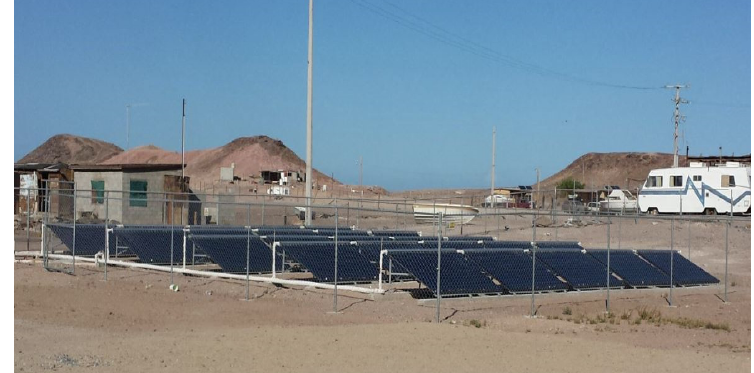
Figure 1. Evacuated tube solar collector field with a bottom parabolic reflector.